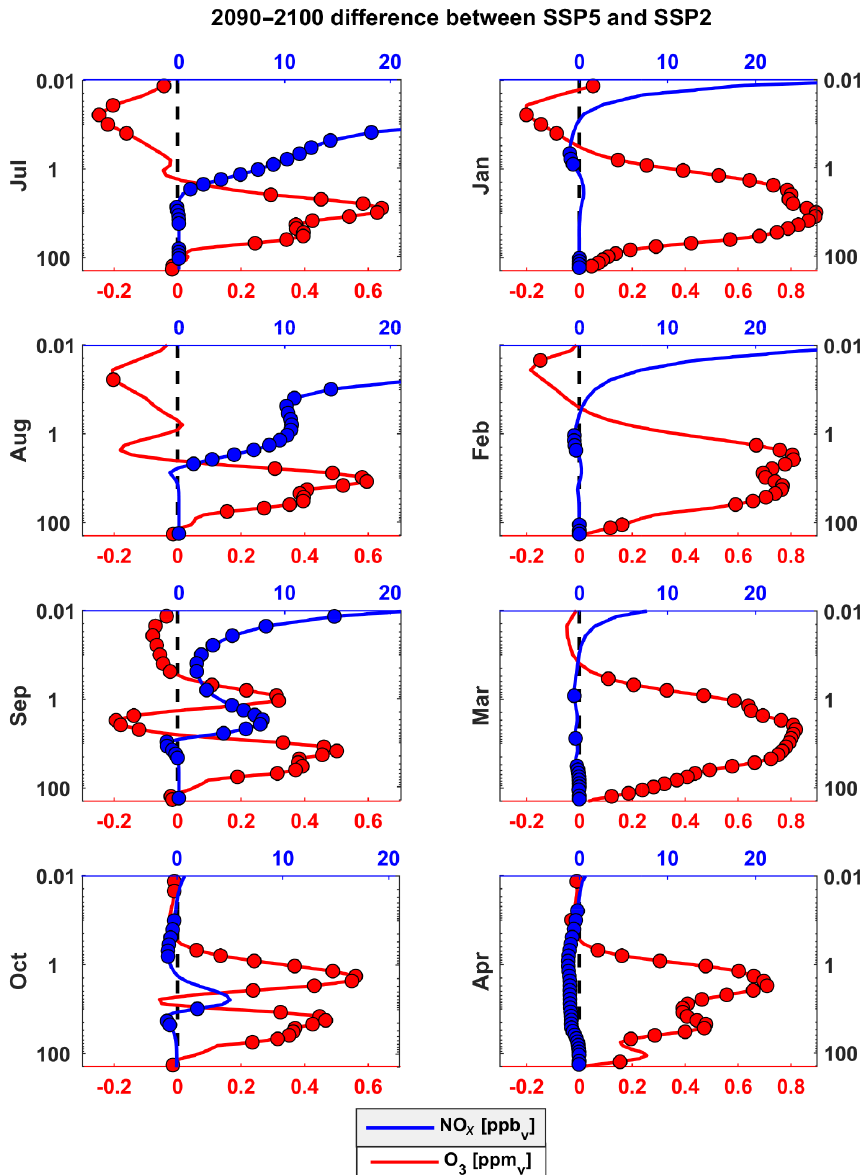
Figure 9. Monthly zonal mean polar (75–90 ◦ S during July–October and 75–90 ◦ N during January–April) NO x (blue, ppb) and ozone (red, ppm) differences between SSP5 and SSP2 during 2090–2100. Vertical axes show the altitude in air-pressure units from 0.01 to 200hPa. Coloured circles represent values significant with 95% calculated with a Monte Carlo simulation and a false detection